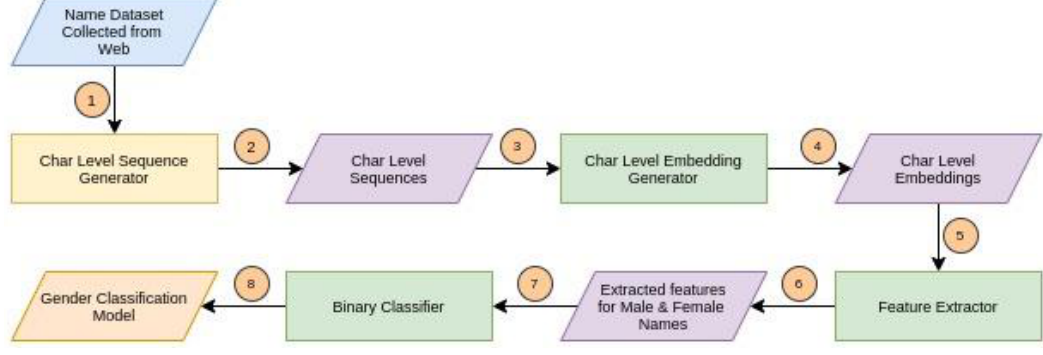
Figure 2. Flow diagram of gender classification from Bengali names.